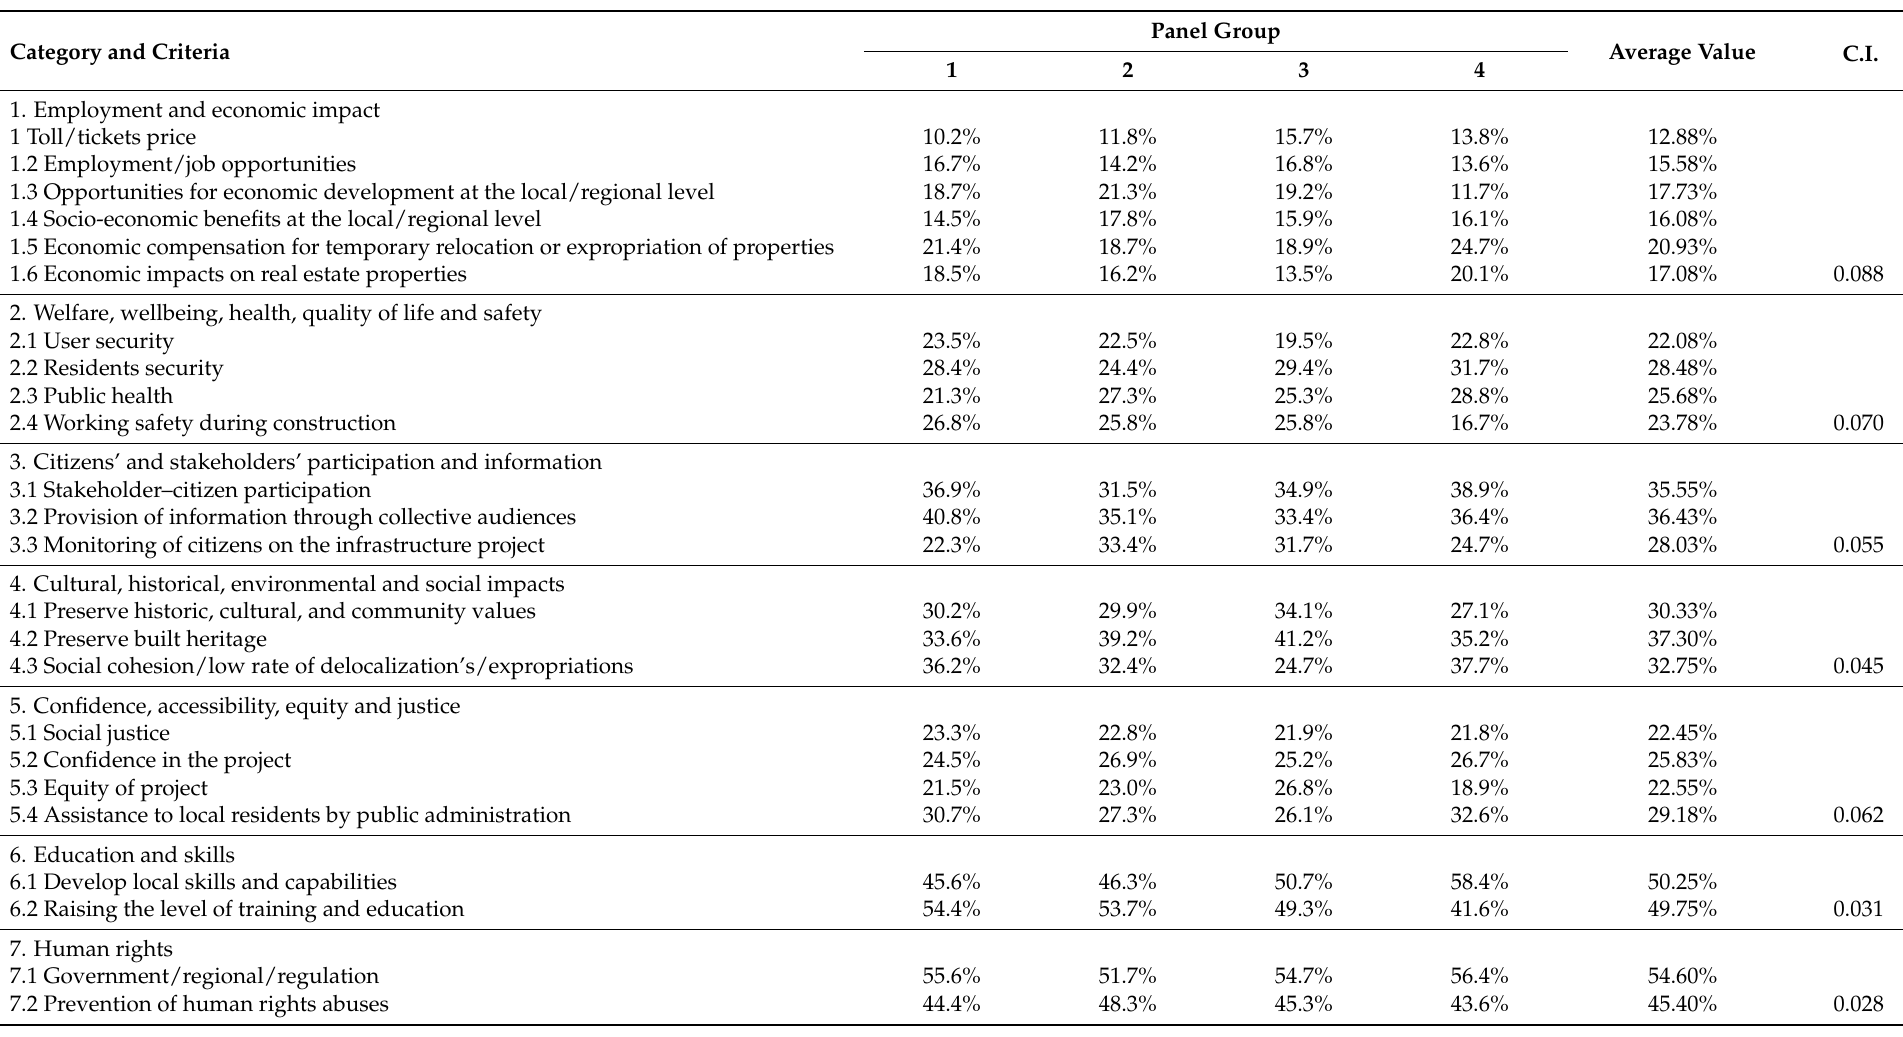
Table 6. Weights of social criterion by Panel